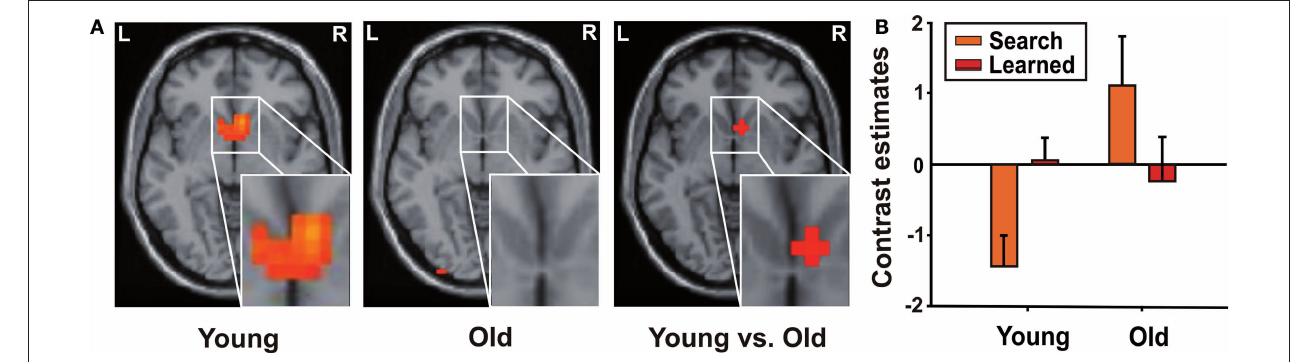
( x = 8, y = 12, z = − 5). In older adults no signifi cant signal changes were observed. (B) Contrast estimates (mean, standard error) of younger and older participants for “search” and “learned” trials in VST.